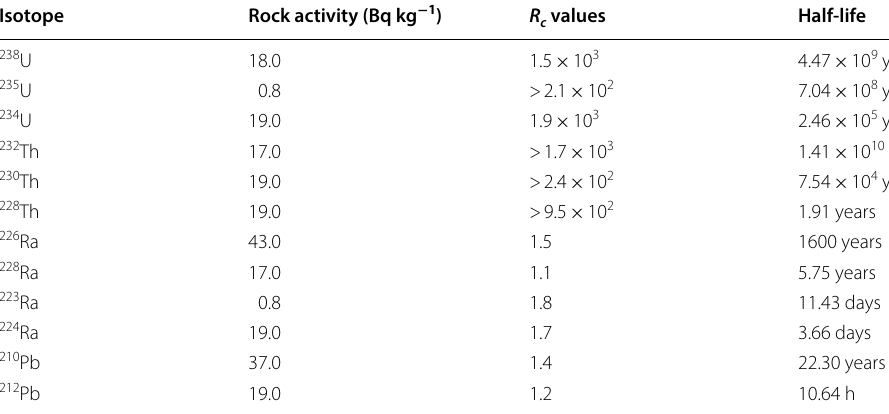
Table 4 R values of Th–U decay series radionuclides c